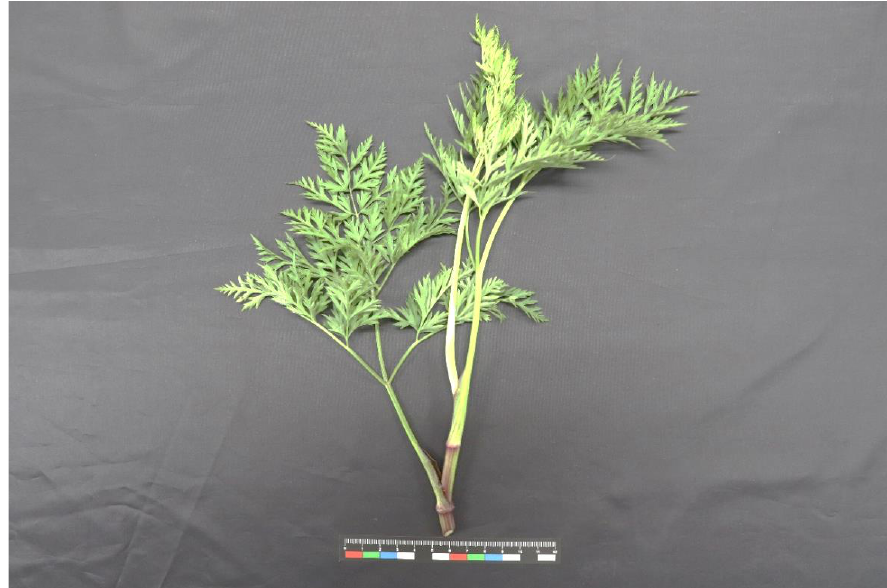
Figure 1. Botanical appearance of